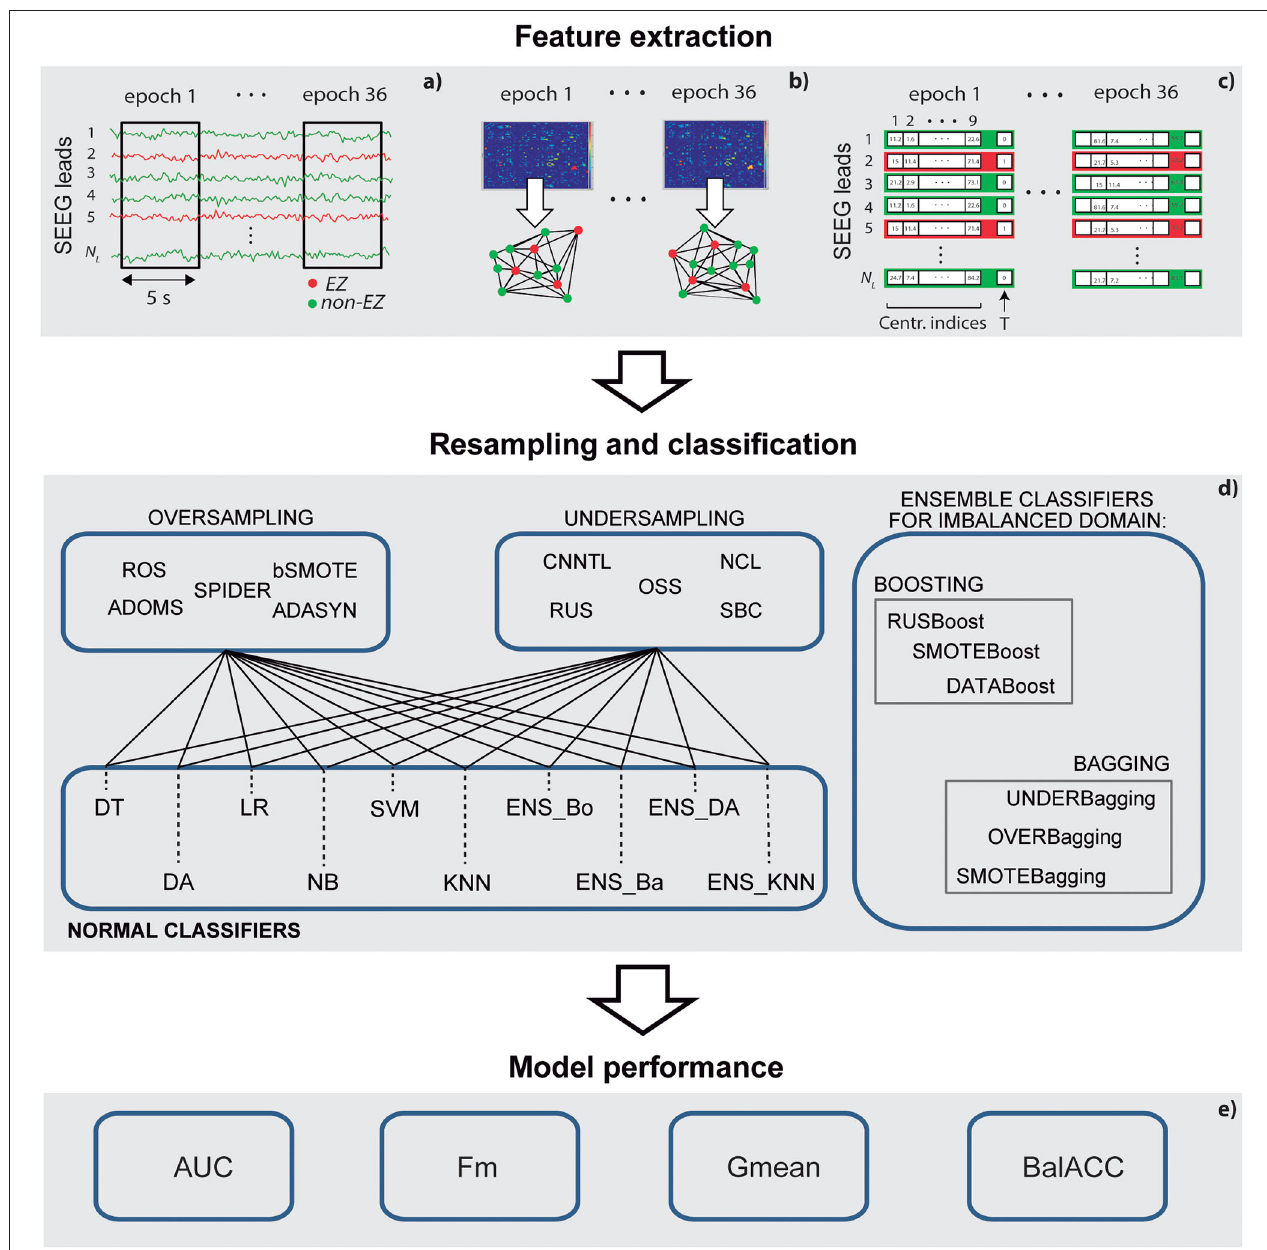
FIGURE 1 | A schematic representation of the methodological pipeline. (a) Stereo-electroencephalography (SEEG) epochs selection; (b) connectivity analysis and graph-based indexes of centrality calculation; (c) feature selection and training and test set definition; (d) set of resampling methods and classifiers applied; and (e) measures to assess the performance of the